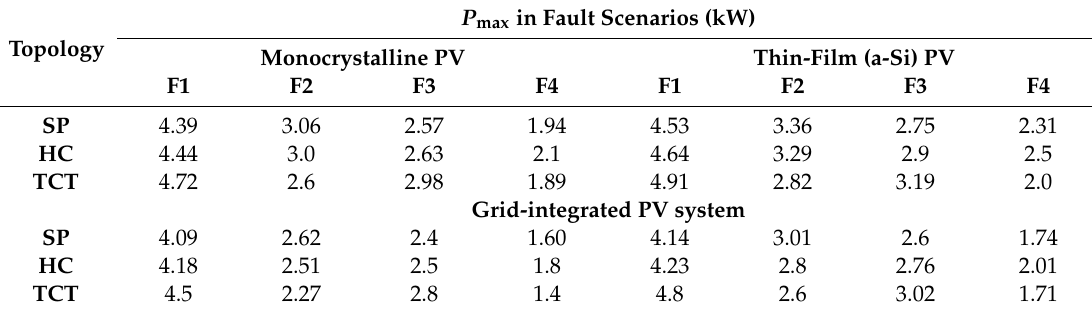
Table 10. Comparison of adopted interconnections in PV array.